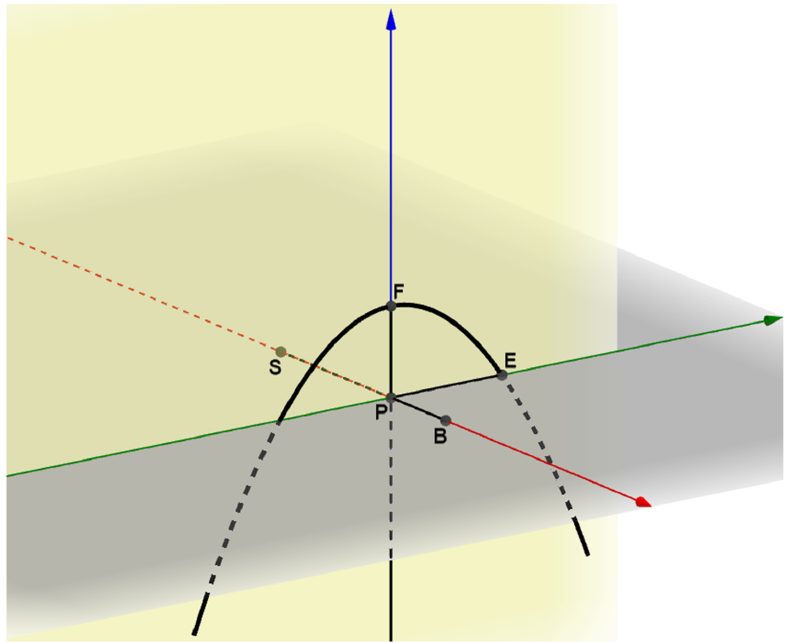
Figure 7. Initial steps for the construction of the cone of which the parabola is a section, according to the method of J. Wallis. From point 𝑆 we draw the parallel to 𝑃𝐹 (Figure 8).